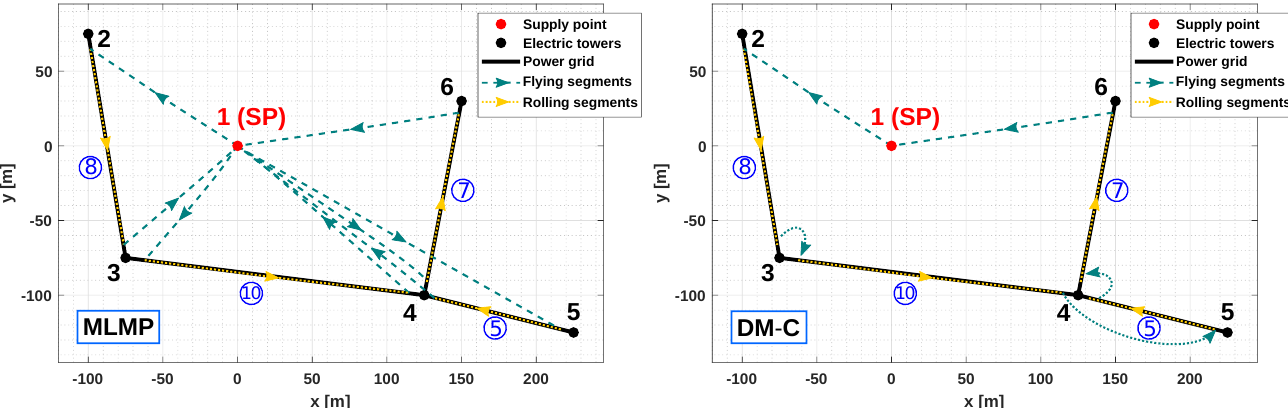
Figure 10. Preliminary planning results for the installation of clip-type bird diverters, using the MLMP platform ( left ) and the DM-C platform ( right